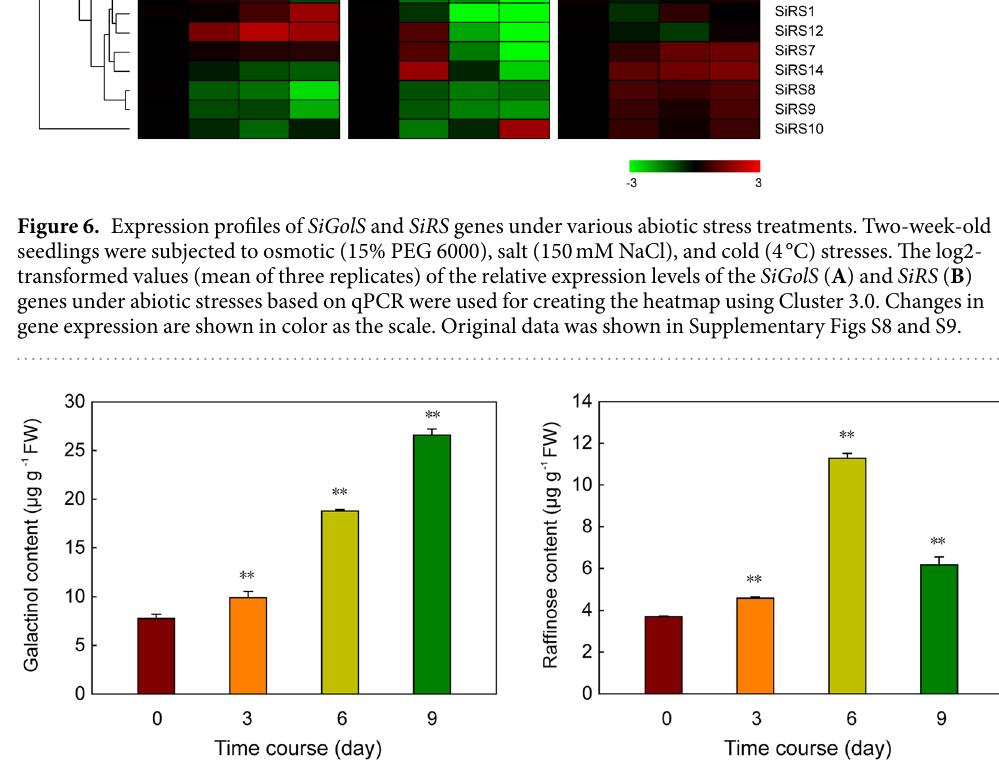
the treatment period, whereas SiGolS1 was only up-regulated at 2 h treatment. Under cold treatment, SiGolS2 and SiGolS7 were significantly repressed during the whole treated time points. As shown in Fig. 6B and Supplementary Fig. S9, 4 SiRSs ( SiRS4 , 5, 6 , and 12 ) were significantly (fold change > 2) up-regulated, while SiRS8 was significantly (fold change > 2) down-regulated during the entire osmotic stress time points. SiRS5 and SiRS6 were significantly induced (fold change > 2) during the salt treatment period, whereas SiRS2, 7, 10, 12 and 14 were only up-regulated or down-regulated at particular time points. Under cold treatment, most of the SiRSs were not significantly affected, while SiRS7 and SiRS14 were significantly (fold change > 2) up-regulated. Together, these results indicated that most of the SiGolS and SiRS genes are active in response to osmotic and/or salt stresses, whereas slightly affected by cold stress (Fig. 6, Supplementary Figs S8 and S9). Galactinol and raffinose content in sesame exposed to osmotic stress. Finally, the changes in the content of galactinol and raffinose in sesame under osmotic stress treatment were investigated. Two-week-old seedlings were treated with 15% PEG 6000, and shoot samples were harvested at 0, 2, 5 and 9 days after treat- ment. As shown in Fig. 7, the content of both galactinol and raffinose clearly increased under osmotic stress, and the most obvious accumulation in galactinol and raffinose were observed at 6 days after treatment. During the osmotic stress treatment, the amounts of galactinol increased continuously. While the raffinose content peaked at 6 days and decreased subsequently.